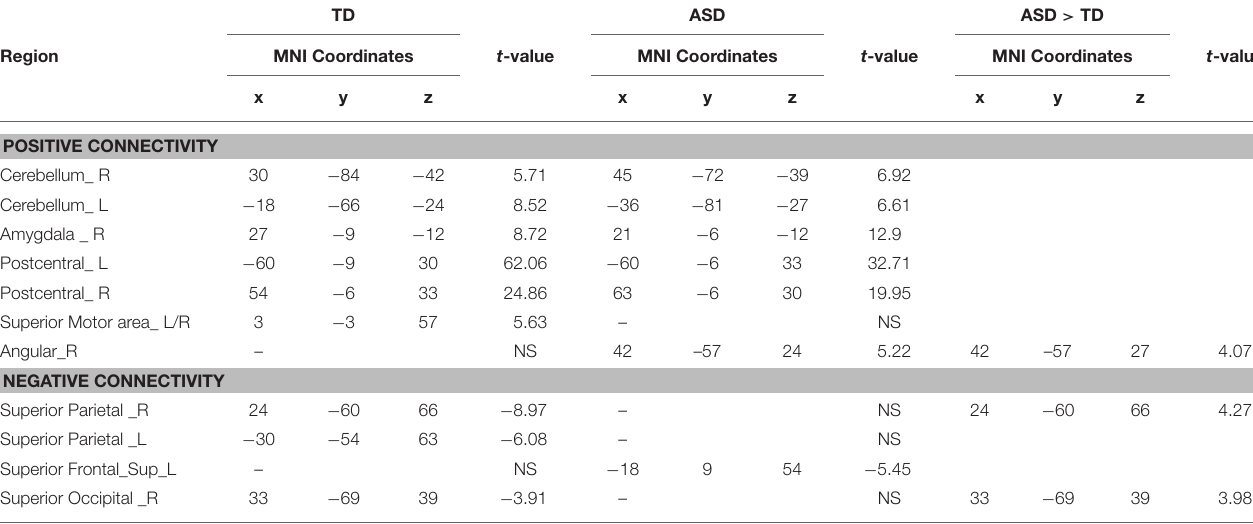
TABLE 2 | Within-group positive and negative connectivity with seed of left PCG and between-group differences. TD ASD ASD > TD Region MNI Coordinates t -value MNI Coordinates t -value MNI Coordinates